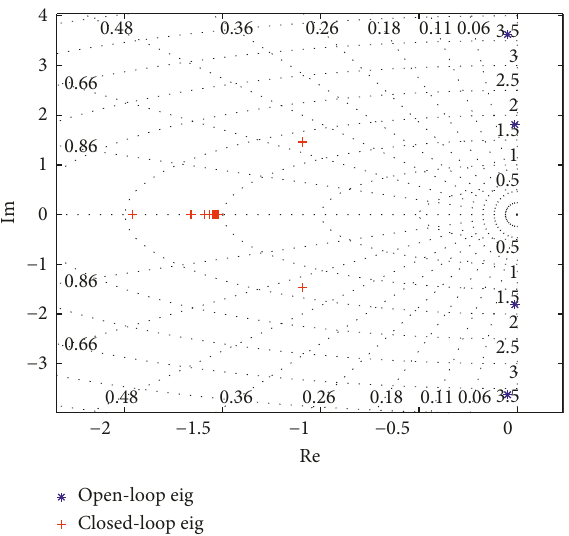
Figure 5: Dominant modes for minimum damping ratio ζ min 0 . 6. (cid:31)